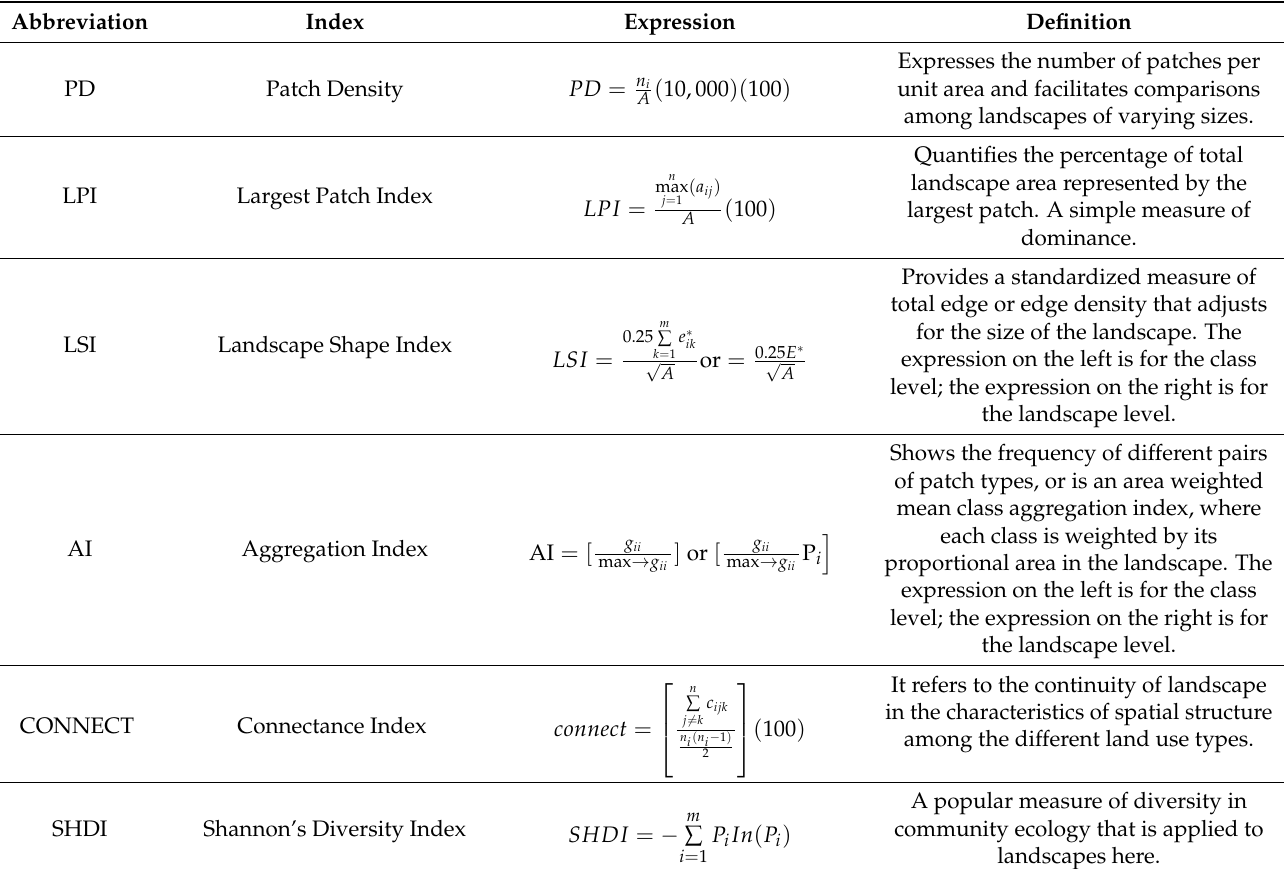
Table 2. The name, formula, and definition of the selected landscape index in this